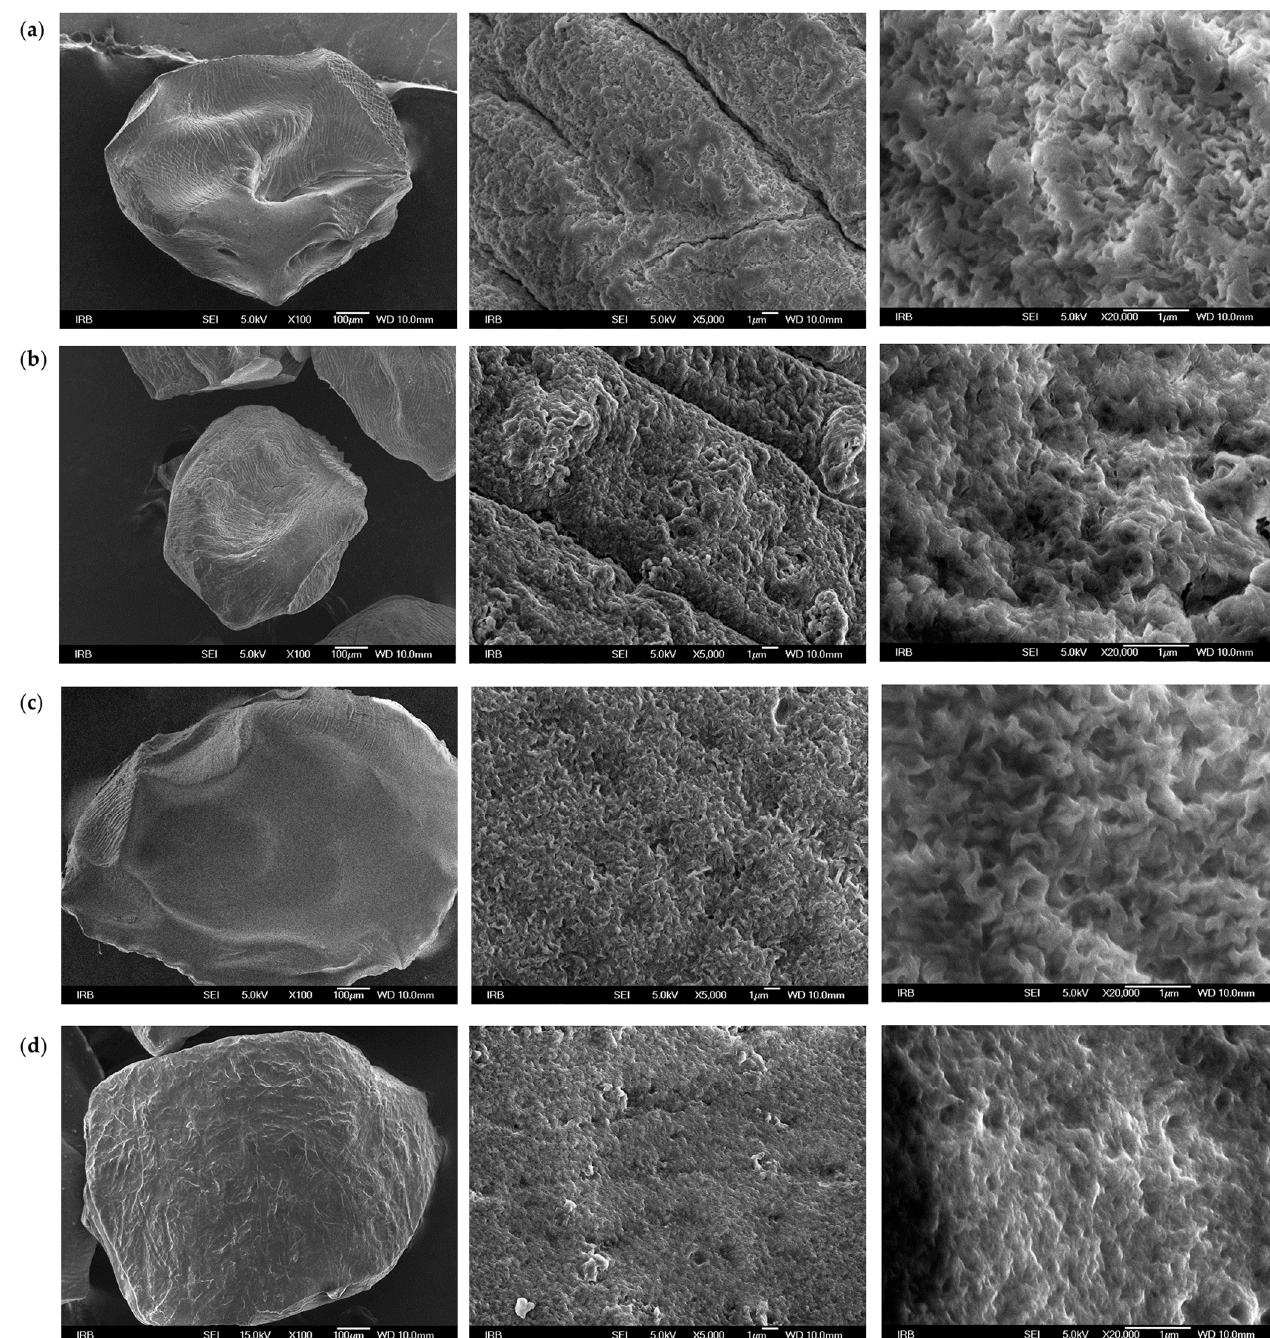
Figure 2. SEM microphotographs of ( a ) Alg ( b ) Alg/Z ( c ) Alg/HPMC, and ( d ) Alg/Z/HPMC microparticles loaded with rosemary extract. Bars are indicated.